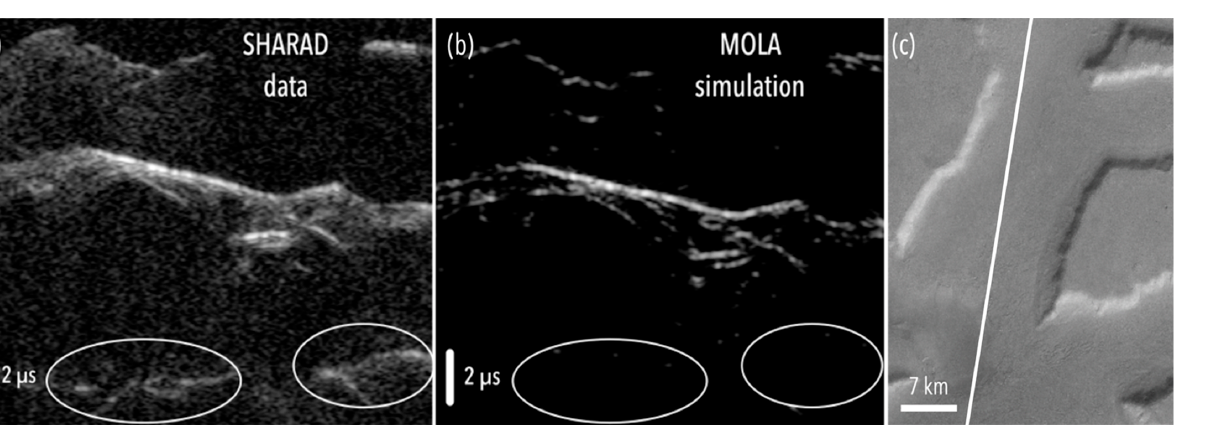
Figure 4. ( a ) A 40 km portion of the SHARAD radargram n°01708401 sounding Hellas Planitia; ( b ) corresponding simulation using a MOLA DTM. ( c ) CTX image of the terrain at the nadir on the area where the radargram was acquired. In areas where the roughness is higher, we can see that the identification of subsurface echoes is much harder with MOLA, as the faintest reflectors are not reproduced by the simulation. 2.4. Limits of MOLA DTMs for Shallow Subsurface Interpretations In most of the southern midlatitudes, the terrain roughness is such that a MOLA de- scription of the surface is not enough to yield satisfying results with simulations. Numer- ous subsurface reflectors could be misidentified and would therefore need further verifi- cations to validate their presence. Surface clutter whose delay is similar to shallow sub- surface reflectors comes from an area that is close to nadir. By geometrical construction, the result of the simulation is very sensitive to small errors in the topography around na- dir, and a high-precision description of the surface is, therefore, needed to avoid misiden- tifications. Around Hellas Planitia, for example, dozens of subsurface reflectors have been